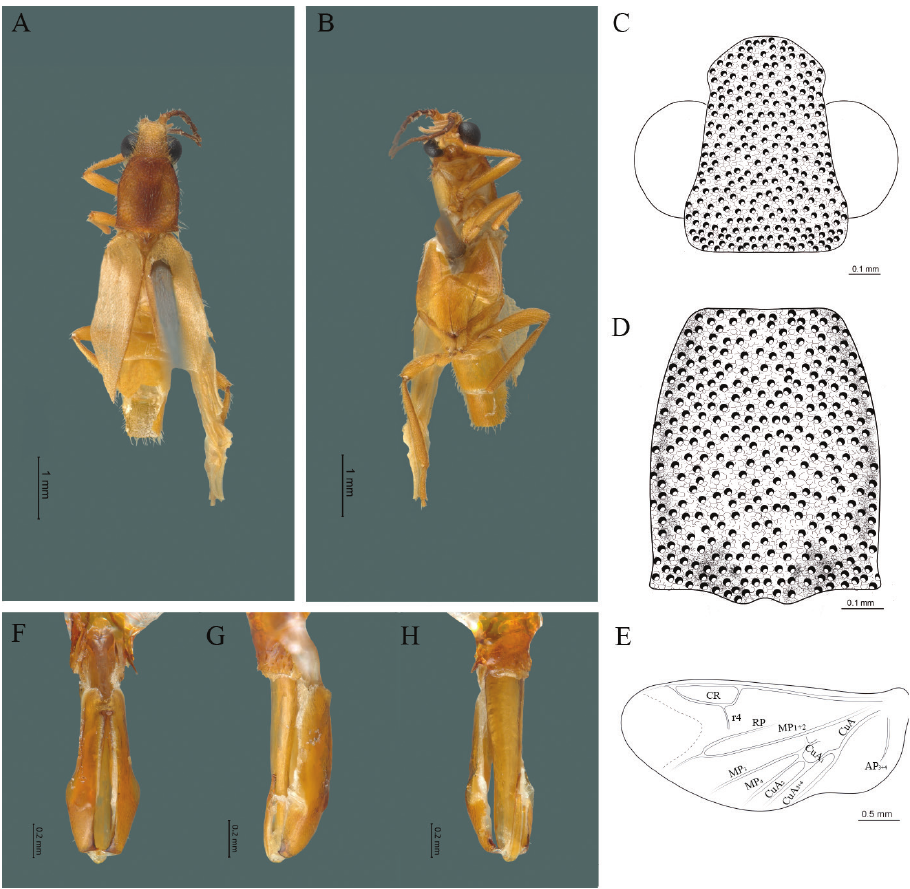
Figure 26. Cenophengus saasil Vega-Badillo, Morrone & Zaragoza-Caballero, sp. nov., male. Habitus: A dorsal B ventral C head dorsal D pronotum dorsal E hind wing. Wing venation: CR = Radial Cell; r4 = radial 4 vein; RP = Posterior Radial vein; MP1+2 = Posterior Median vein; CuA = Cubital vein; AA and AP = Anterior and Posterior Anal veins. Aedeagus: F dorsal view G lateral view H ventral